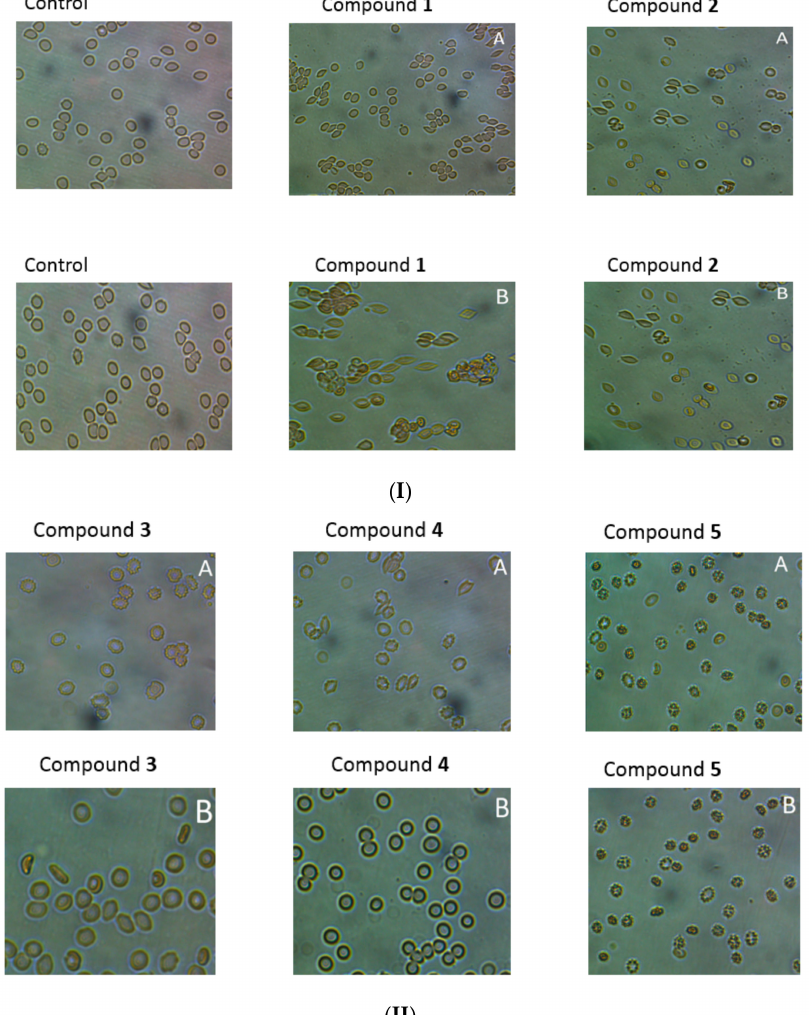
Figure 8. ( I ) Effect of iminodiacetic acid derivatives on erythrocytes morphology. 2% erythrocyte suspension was treated at 37 ◦ C for 60 min with indicated concentrations of compound 1 and 2